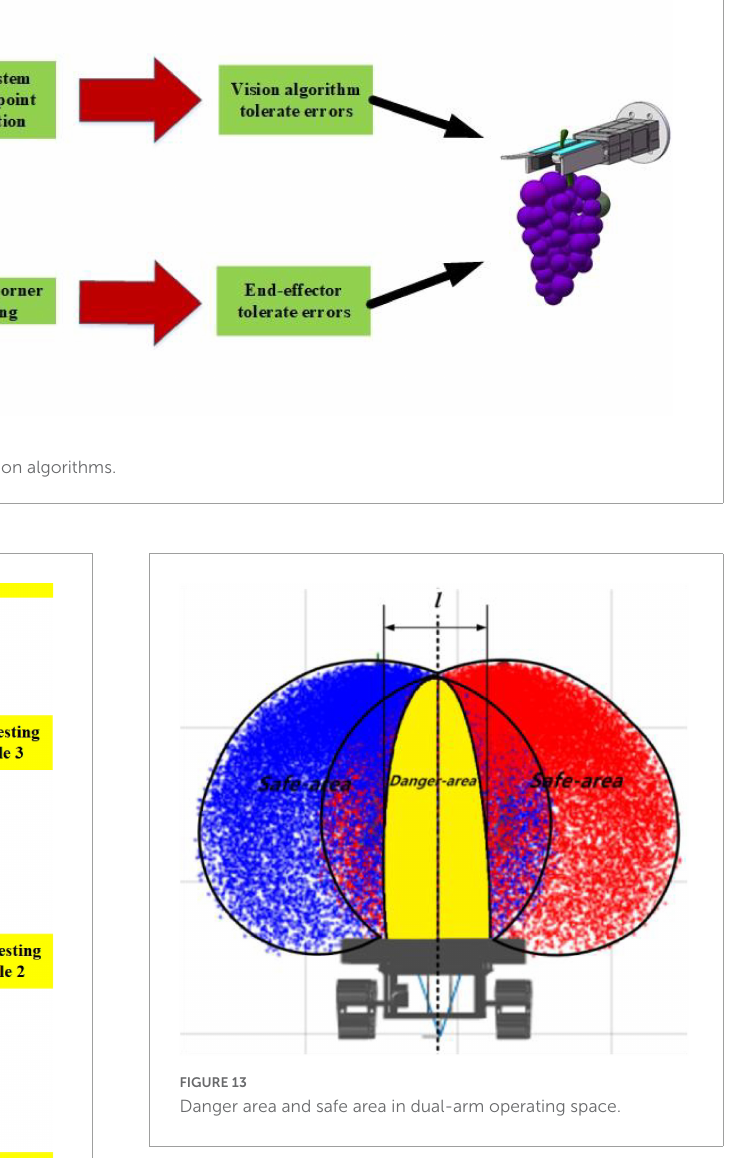
space. The fixed area in yellow shown in Figure 13 can be named the danger area. This means that we need to perform two scenario